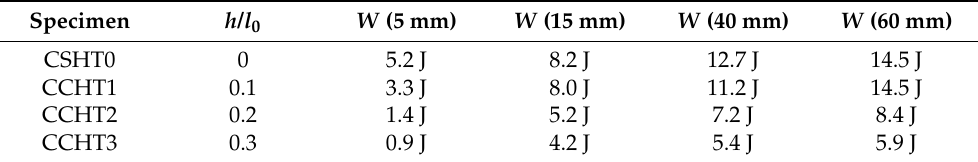
Table 4. The energy absorbed by the specimen when the displacement is 5 mm, 15 mm, 40 mm, and 60 mm under dynamic test.